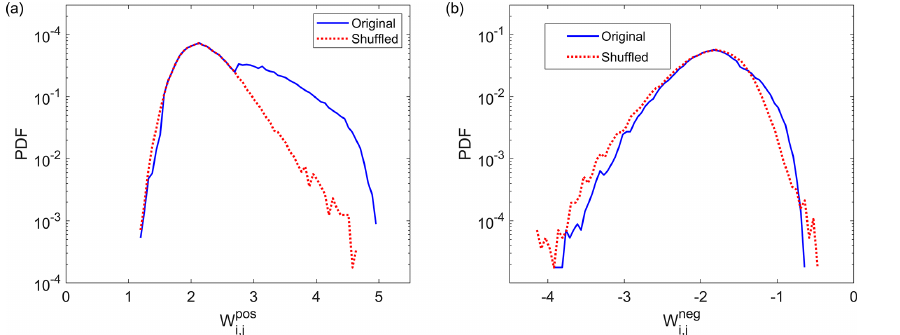
Figure 3. PDF of positive (a) and negative (b) link weights for the original data and shuffled data. The blue lines represent the original data, and the dashed red lines denote the shuffled cases.